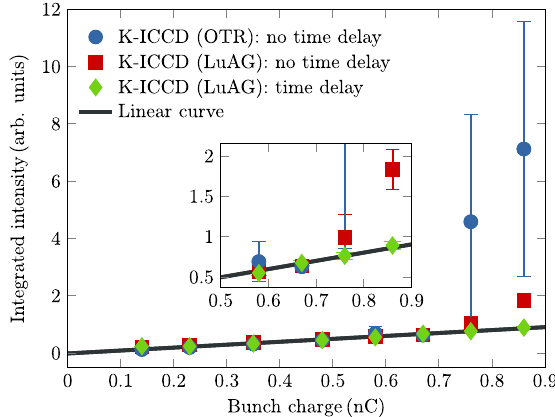
FIG. 8. Measurements on the bunch charge dependence of the integrated intensity at K-ICCD generated by compressed elec- tron bunches using different screen/readout configurations, where the inset shows the range from 0.55 to 0.9 nC. The linear curve shows the dependence of incoherent